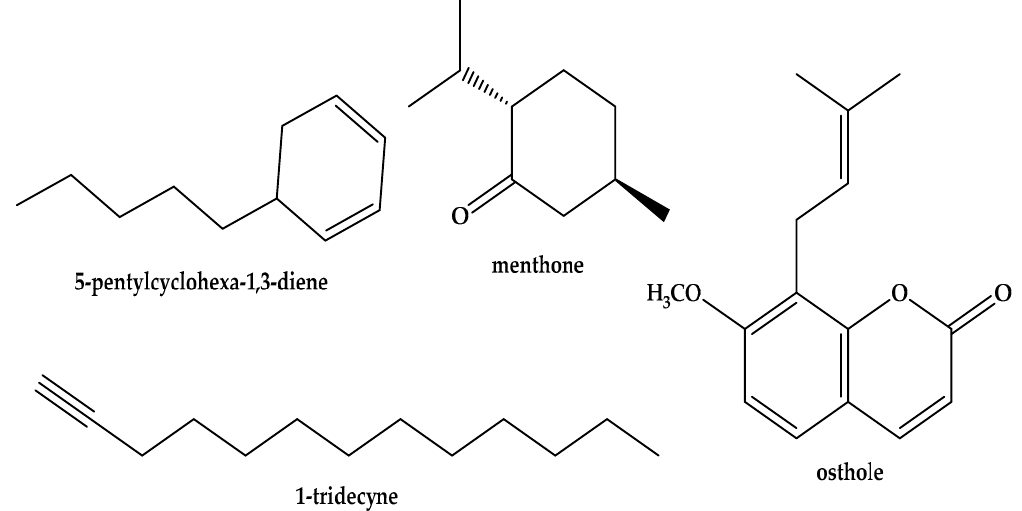
Figure 1. Structures of the main components of Prangos pabularia essential oil.